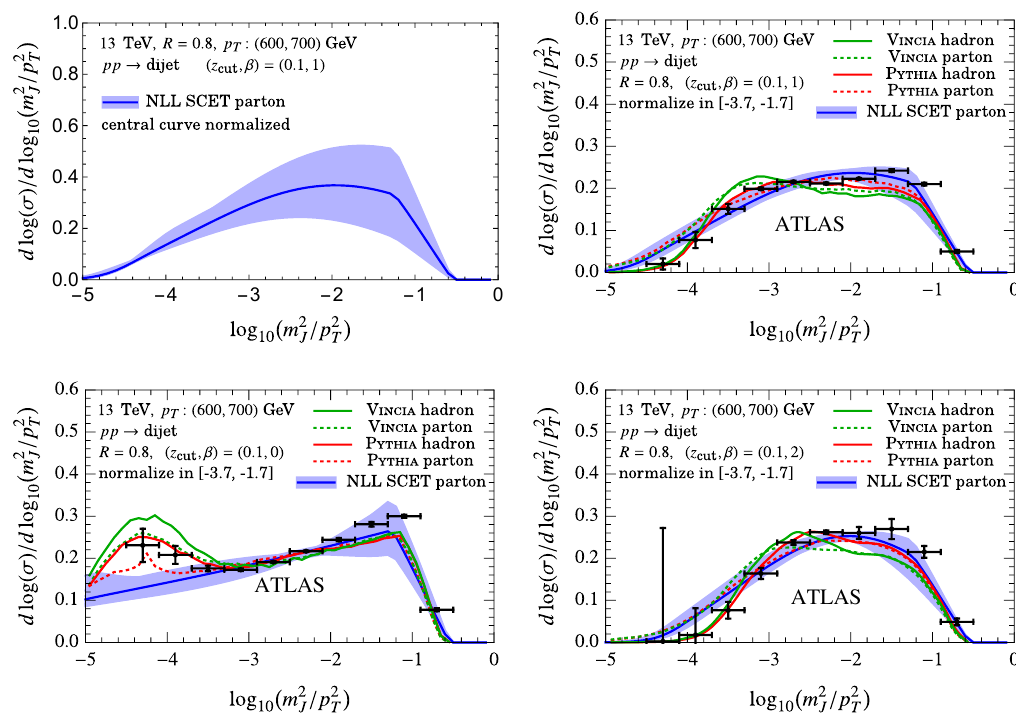
Figure 5 . Comparisons of soft drop jet mass distributions with z cut = 0 : 1 and (cid:12) = 0 ; 1 ; 2 in proton-proton collisions at 13 TeV. The solid blue curves represent the partonic NLL SCET results with uncertainty band estimated by scale variation. The top-left panel includes normalization uncer- tainty, whereas the remaining panels do not. Results are also shown for partonic and hadronic+MPI simulations from Pythia and Vincia , and compared to ATLAS data